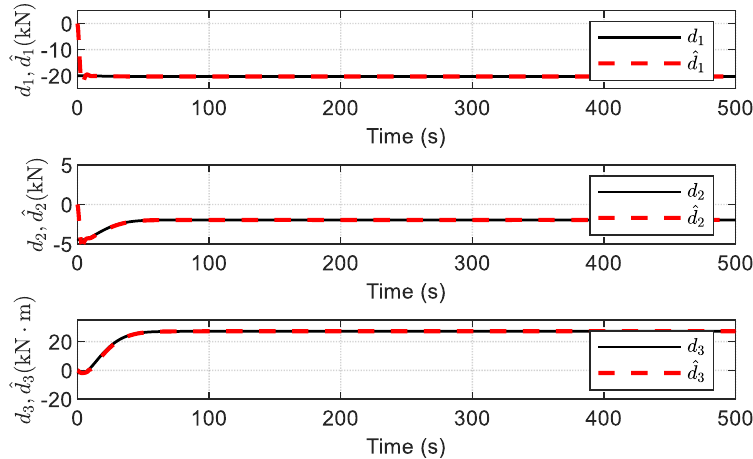
Figure 22. Estimation of disturbances via ADO.